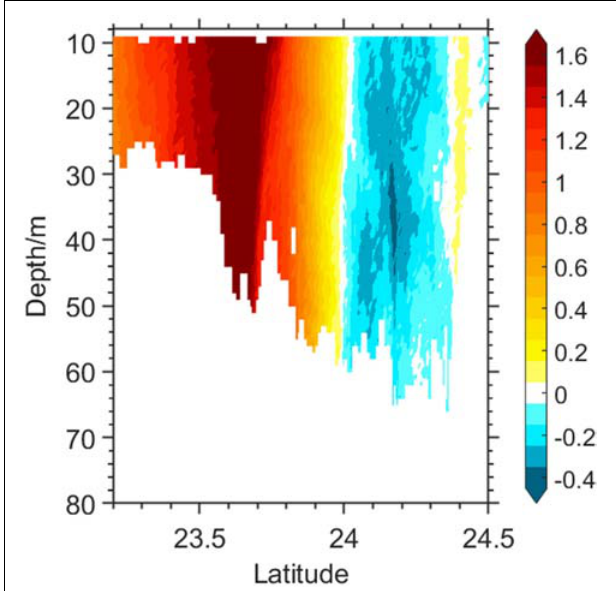
FIGURE 7 | Vertical profile of current velocities (unit: m/s) in directions normal to the ship’s track, measured by the shipborne ADCP during May 24–25, 2017. The ship’s track is annotated in Figures 2I, 2J , 6A . Color scale denotes the current speed, positive to the east and negative to the